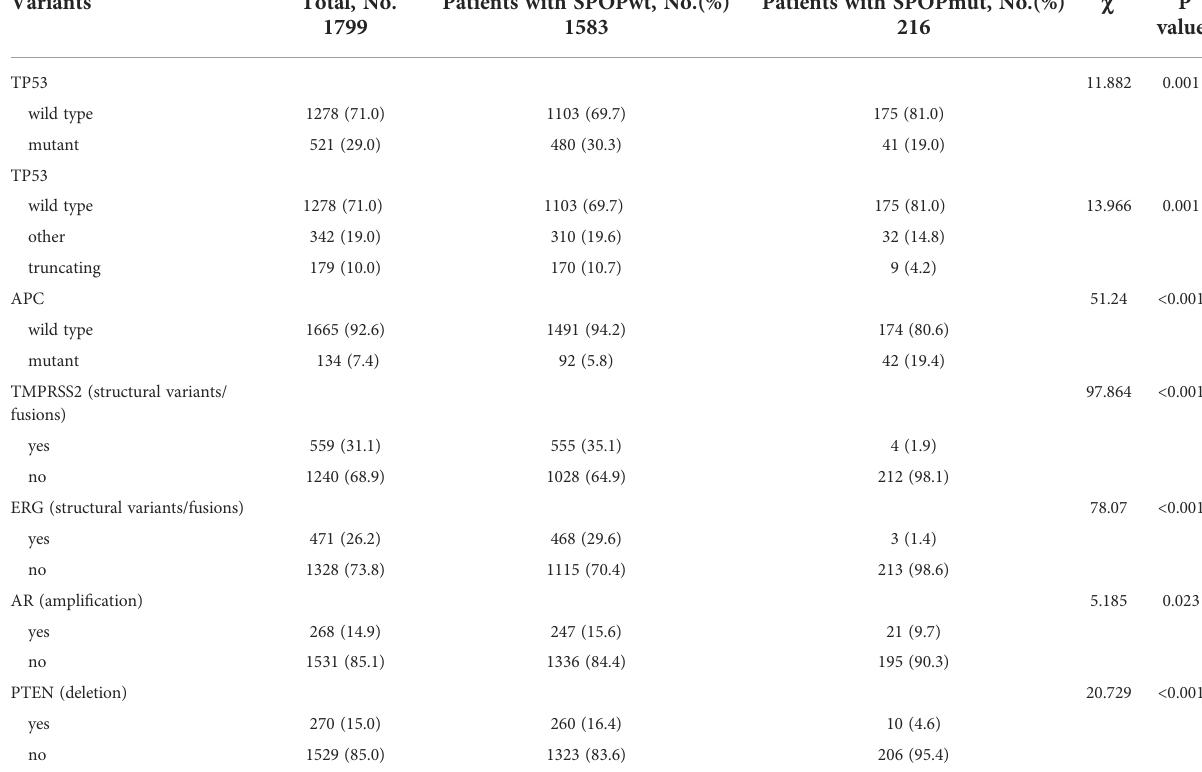
TABLE 2 Signi fi cant genomic alterations between SPOPwt and SPOPmut